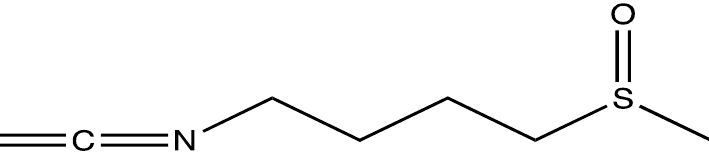
Figure 7. Structure of sulforaphane, an abundant sulphur compound in cruciferous vegetables.